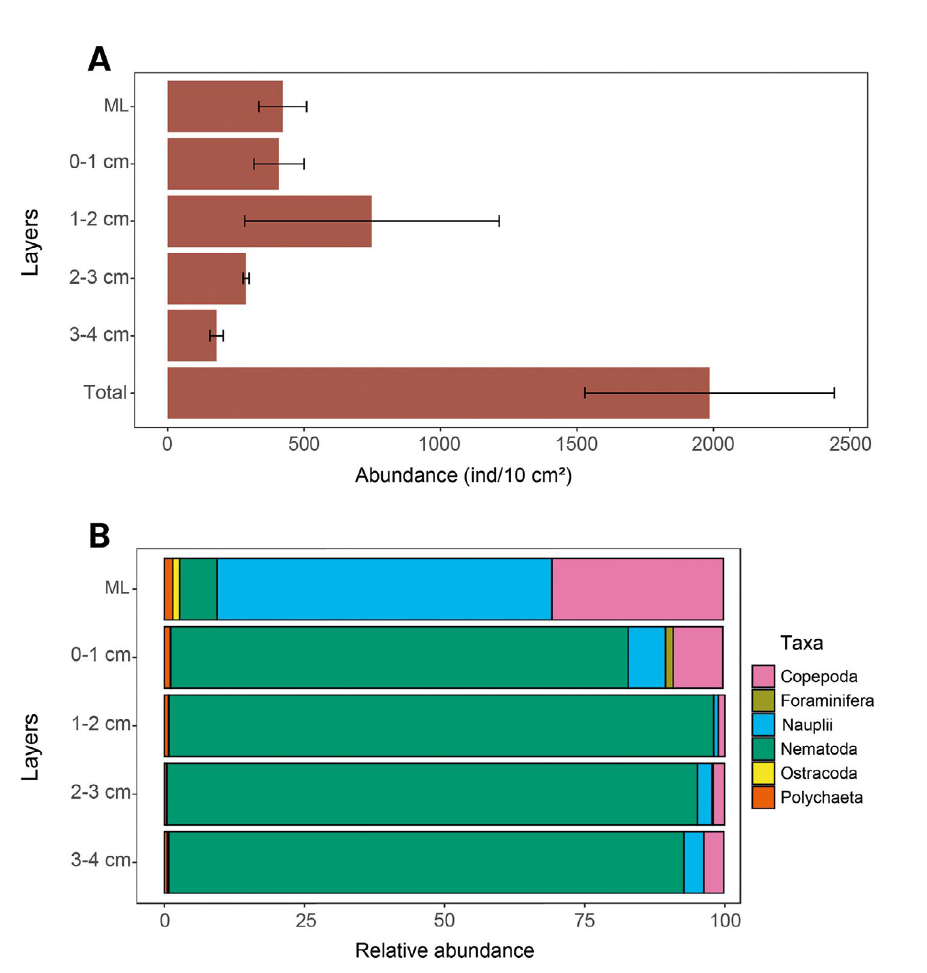
Fig. 2. – A, vertical distribution of total meiofaunal abundance in the maerl bed (ind/10 cm²). B, meiofaunal community structure in the maerl bed (as percentages of dominant higher taxa). Horizontal bars are standard deviations. ML, Maerl Layer at the top (including maerl without